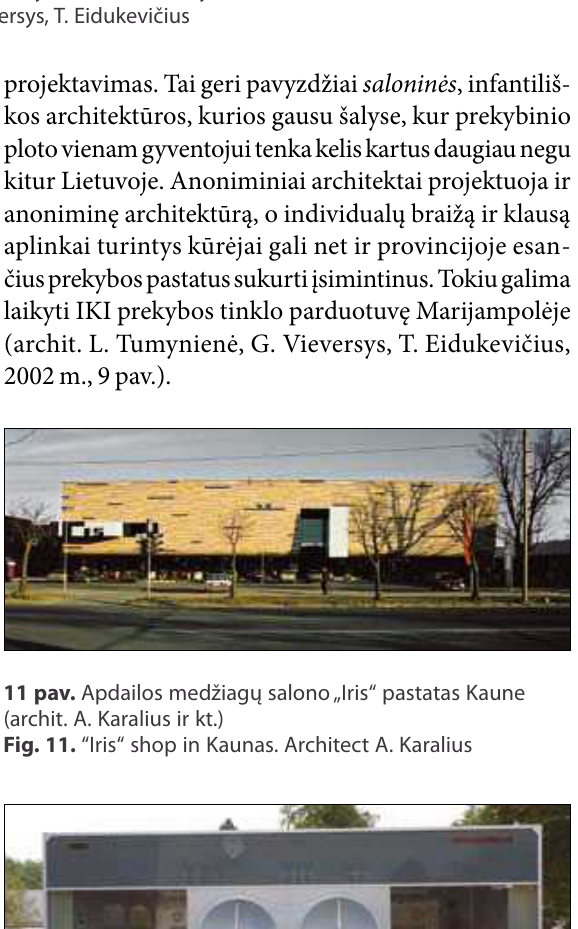
Fig. 9. iki shop in Mar­ijampolė. a­r­chitects L. tu­mynienė, G. Viever­sys, t. eidu­kevičiu­s